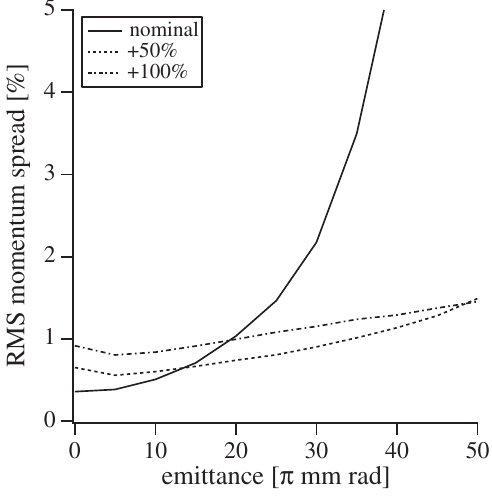
FIG. 5. Final momentum spread as a function of initial trans- verse emittance with different accelerating voltages.